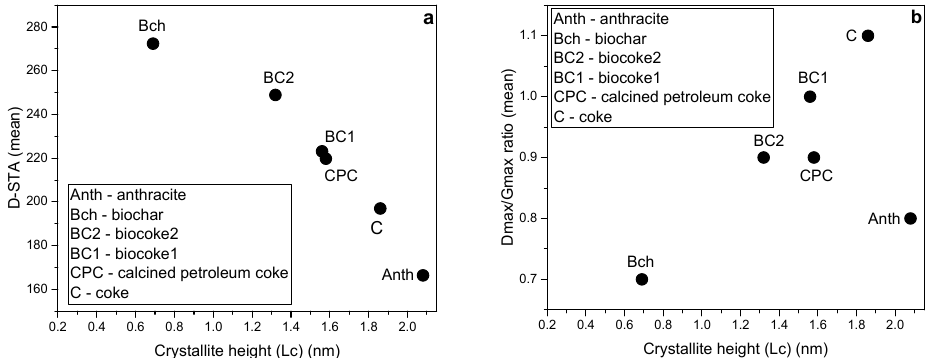
Figure 9. Relationship between the parameters of crystallite height (L c ) and selected Raman parameters. ( a ) Relationship between crystallite height (L c ) and D-STA (mean). ( b ) Relationship between crystallite height (L c ) and the Dmax/Gmax ratio (mean).